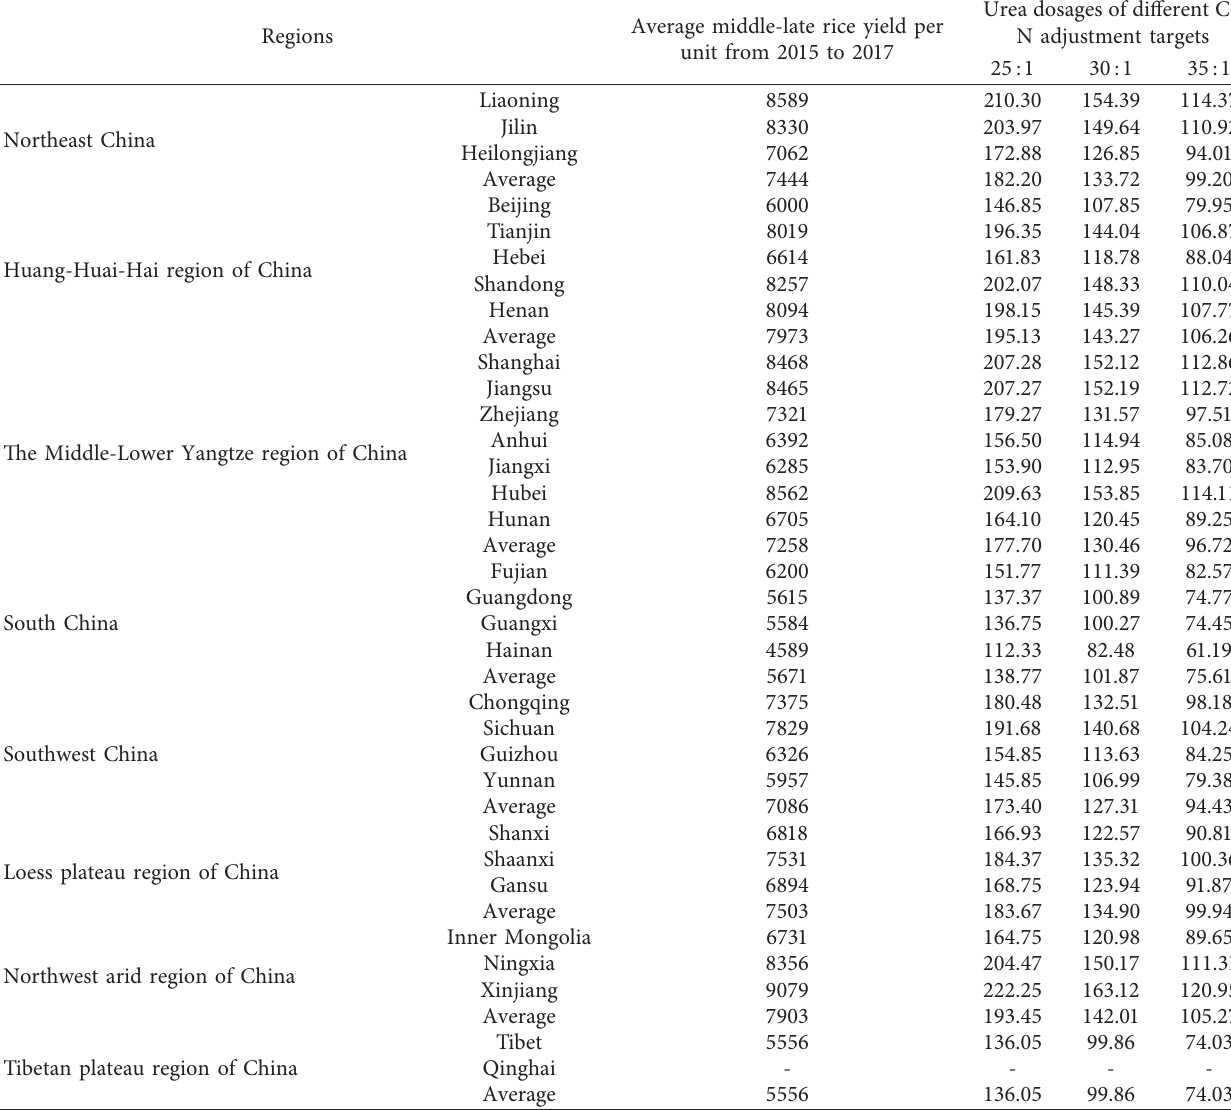
Table 9: Enquiry table for urea applied to middle-late rice straw returning to field in all regions of China and provinces (cities, autonomous